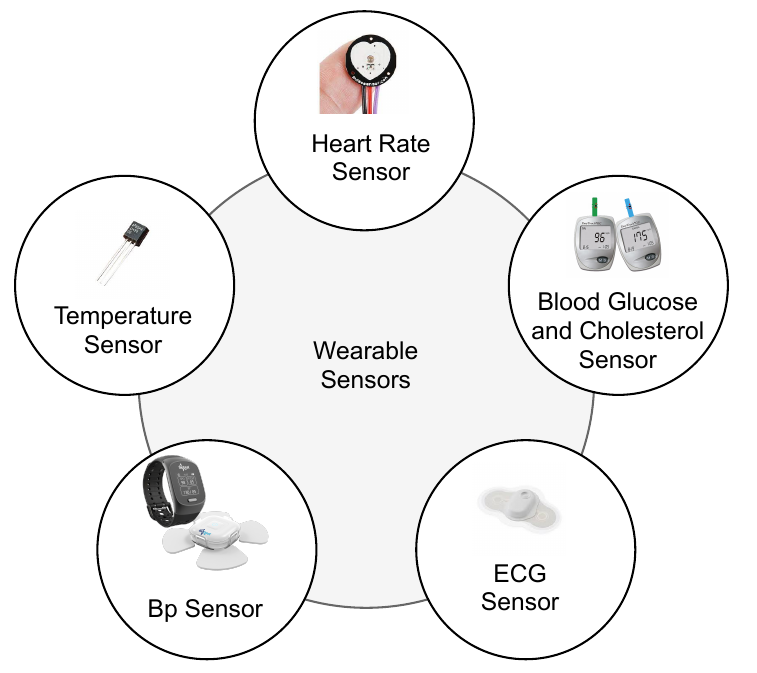
Figure 2. IoT-based Sensors to monitor patient health.